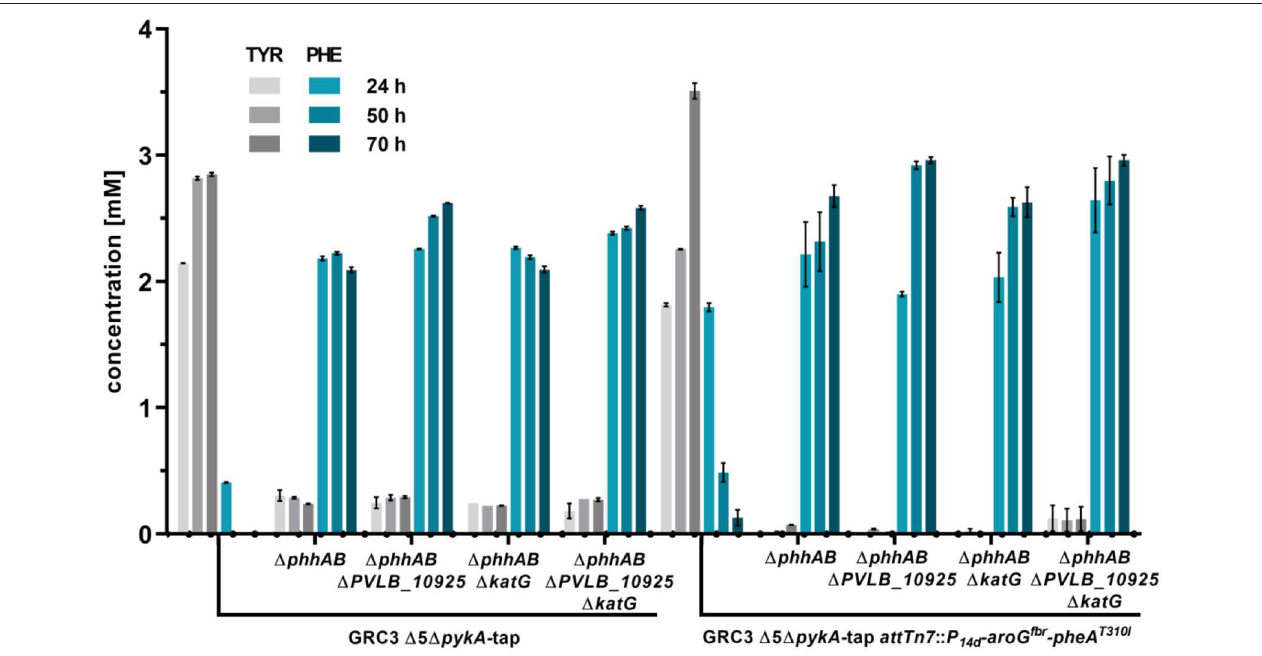
FIGURE 3 | L -phenylalanine and L -tyrosine accumulation of P. taiwanensis GRC3 1 5 1 pykA -tap and subsequent mutants with deletions to prevent L -phenylalanine degradation and additional overexpression of AroG fbr and PheA T310I . The strains were cultivated in MSM containing 20mM glucose in a System Duetz ® shaker. Error bars represent the standard error of the mean ( n =